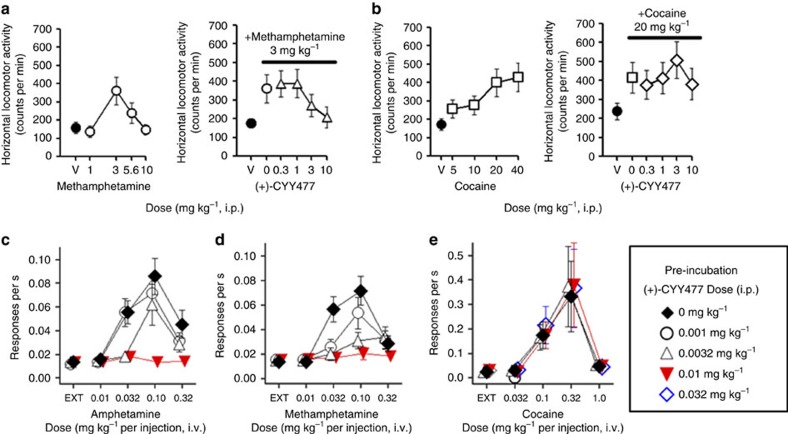
Acute (+)-CYY477 pretreatment selectively antagonizes behavioural effects of amphetamine and methamphetamine in rodents.(a) Methamphetamine stimulation of horizontal locomotion in mice. Left panel: methamphetamine increased activity in a dose-related manner with maximal elevation at a 3 mg kg−1 i.p. dose (open points). ‘V' (vehicle) indicates locomotor activity rate after two saline vehicle injections (closed point). Right panel: locomotion stimulated by 3 mg kg−1 methamphetamine (solid bar) was antagonized by acute preinjection of (+)-CYY477 in a dose-dependent manner (open triangles) (b) Cocaine stimulation of horizontal locomotion in mice. Left panel: dose-related increases in activity (open squares, ‘V' two saline injections). Right panel: Locomotion stimulated by 20 mg kg−1 cocaine (solid bar) was unaffected by acute preinjection of (+)-CYY477 up to 10 mg/kg doses (open diamonds). (a,b) all drug doses were administered i.p. Mean and s.e.m. from six mice per group. (c–e) Selective antagonism by (+)-CYY477 of self-administration of psychostimulants in rats. Acute (+)-CYY477 pretreatment dose-dependently attenuated self-administration of both amphetamine (c) (P<0.001) and methamphetamine (d) (P<0.001). For self-administration rates (0.10 mg kg−1 per injection of either amphetamine): (+)-CYY477 0.001 mg/kg (t⩾2.33; P≤0.14), 0.0032, mg kg−1 (t⩾3.87; P≤0.002), 0.01 mg kg−1 (t⩾9.03; P<0.001). Two-way repeated measure ANOVAs also indicate significant effects on amphetamine doses (F(4,60)=21.8, P<0.001) and methamphetamine doses (F(4,60)=23.6, P<0.001). (e) Cocaine self-administration was not diminished by acute (+)-CYY477 pretreatment at any dose tested. (c–e) Ordinates: responses per s; abscissae: psychostimulant dose ( mg kg−1 per injection, i.v.). Each point represents the mean±s.e.m. of response rates on the active lever in six rats per group; EXT: extinction (no injection). ‘0 mg/kg' of (+)-CYY477 indicates vehicle (saline-only) pretreatment. i.p., intraperitonially; i.v., intravenous.